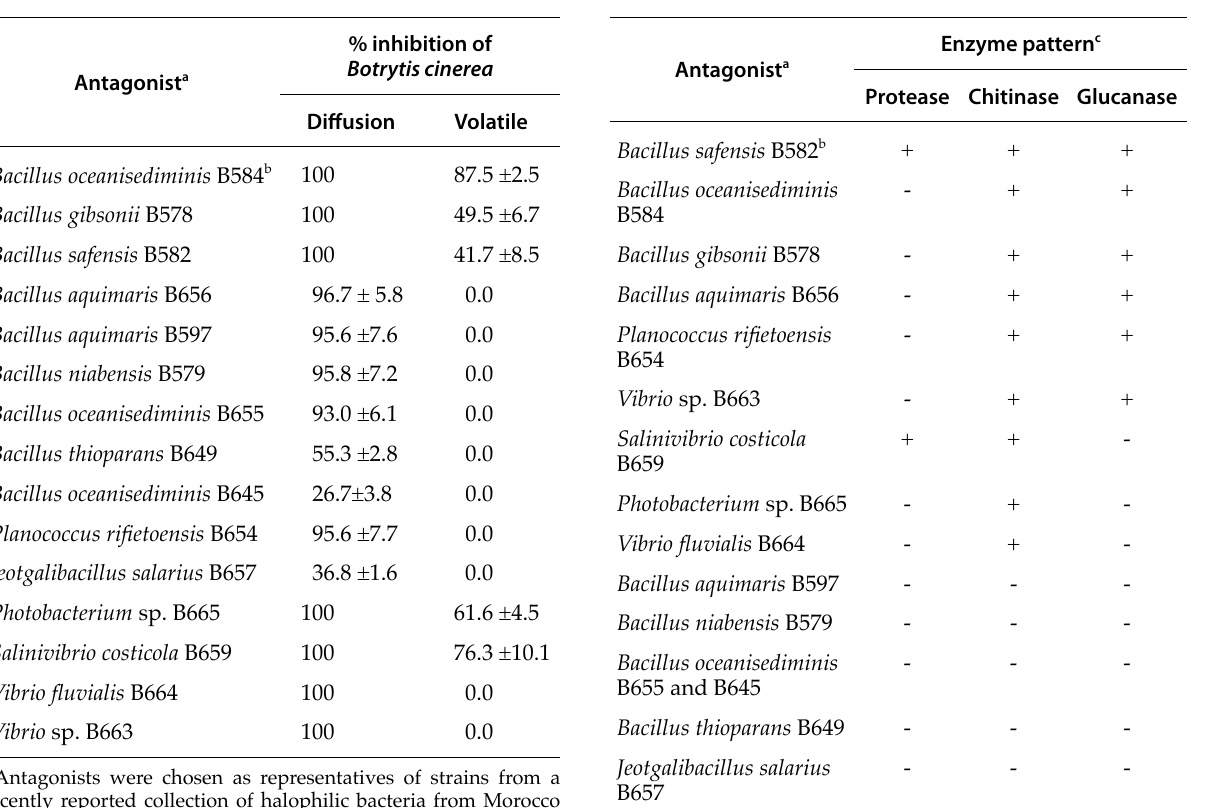
Table 1. In vitro screening of bacterial isolates for their anti- fungal activities against Botrytis cinerea